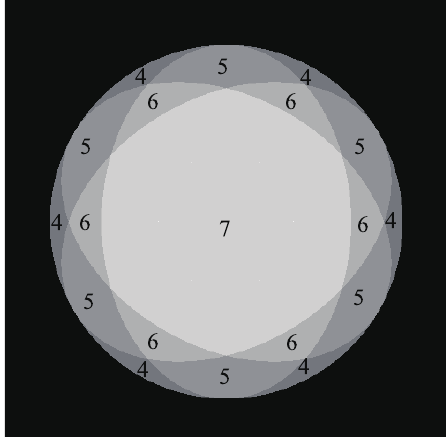
Figure 11. Gaussian sphere representation of the surface normal where the north pole is the center of this picture. The number indicates how many light sources are lit for each direction of surface